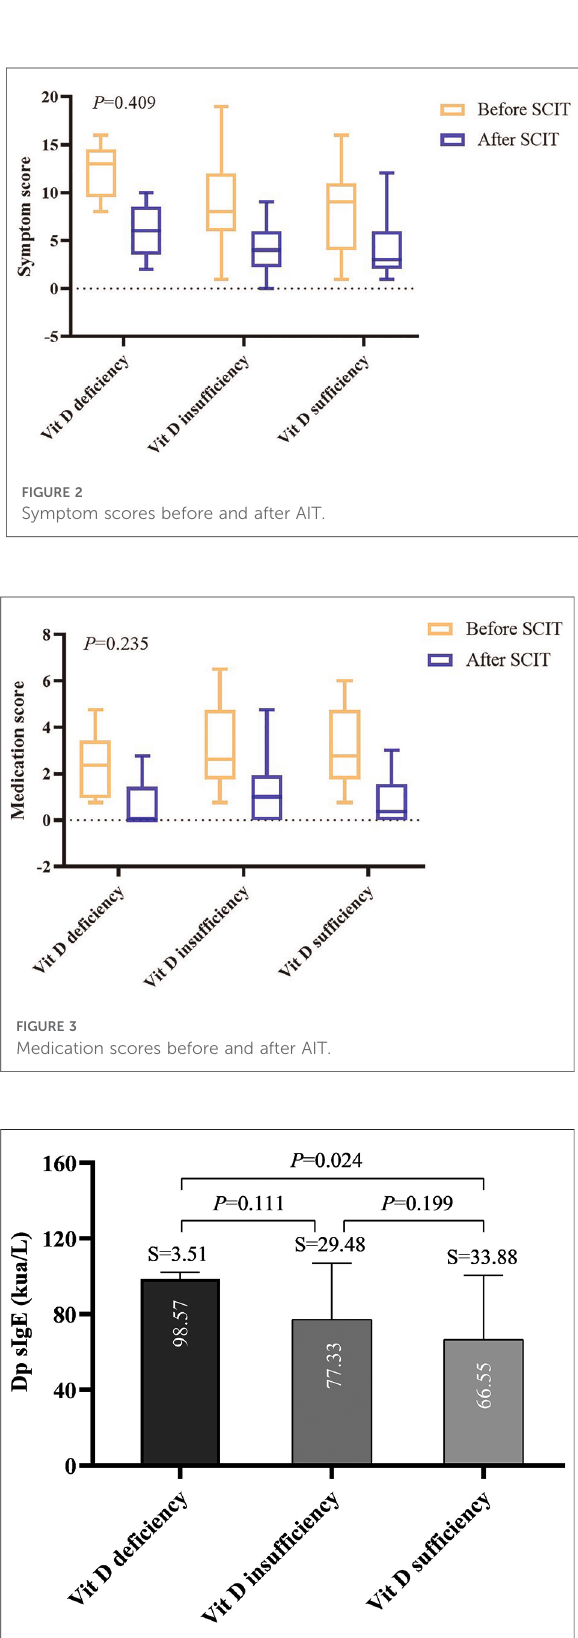
FIGURE 4 Dermatophagoides pteronyssinus (Dp) sIgE in different